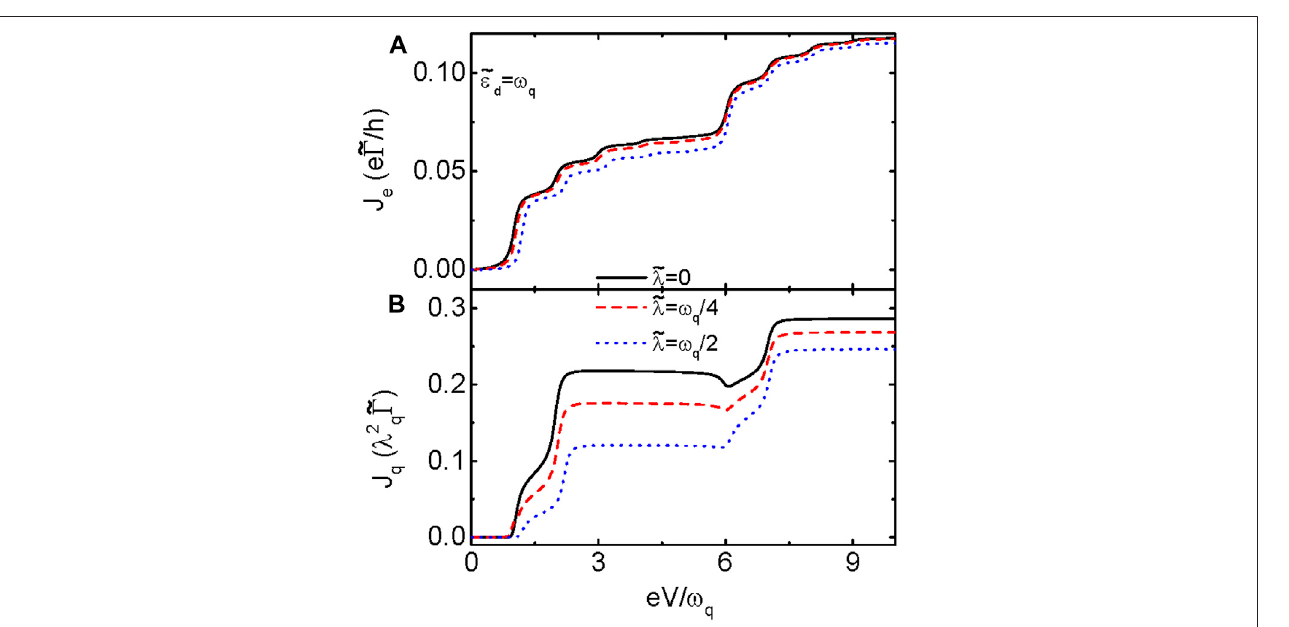
FIGURE 2 | J e in (A) and J q in (B) versus the bias voltage when the QD is coupled to regular fermions in another QD. As the present manuscript focuses on the NDHG occurred at non-zero dot level, here only the results of λ q (cid:1) ω q is presented. Other parameters are the same to those in Figure 2 .